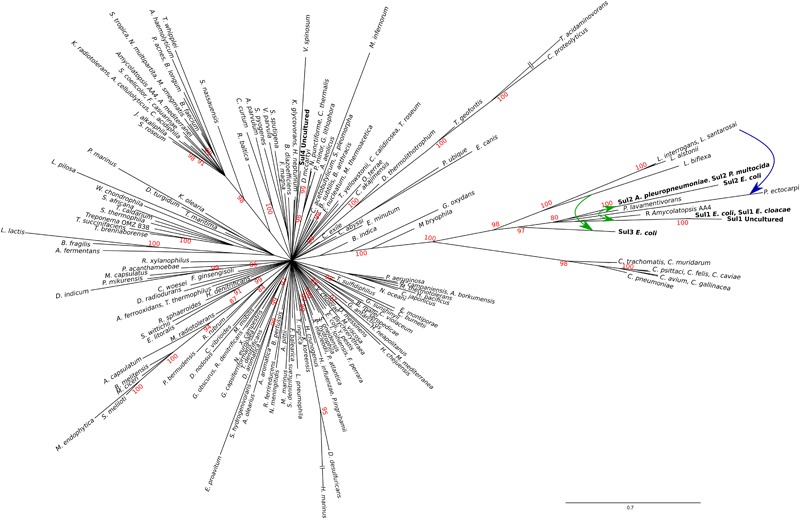
Consensus tree of Sul/FolP protein sequences. Branch support values are provided as Bayesian posterior probabilities. For clarity, only posterior probability values higher than 0.8 are displayed. Proposed lateral gene transfer and mobilization events are shown by means of superimposed continuous and dotted, respectively, arrows.